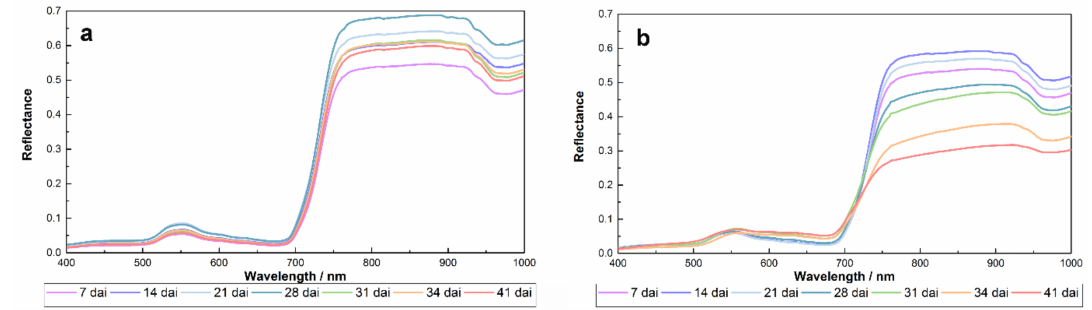
Figure 2. Averaged leaf spectra for ( a ) healthy- and ( b ) rust infected-leaves at different days after infestation